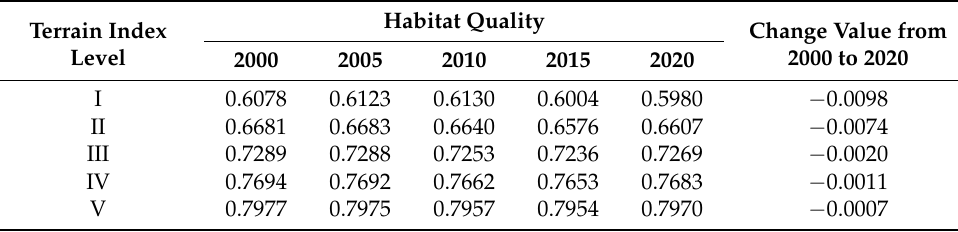
Figure 12. Relationship between terrain index and habitat quality in the counties of Shiyan from 2000 to 2020. (Note: the values in the column on the right side of the figure correspond to the topographic position index of each county.) Table 7. Habitat quality for each terrain index level in Shiyan from 2000 to 2020 shown as